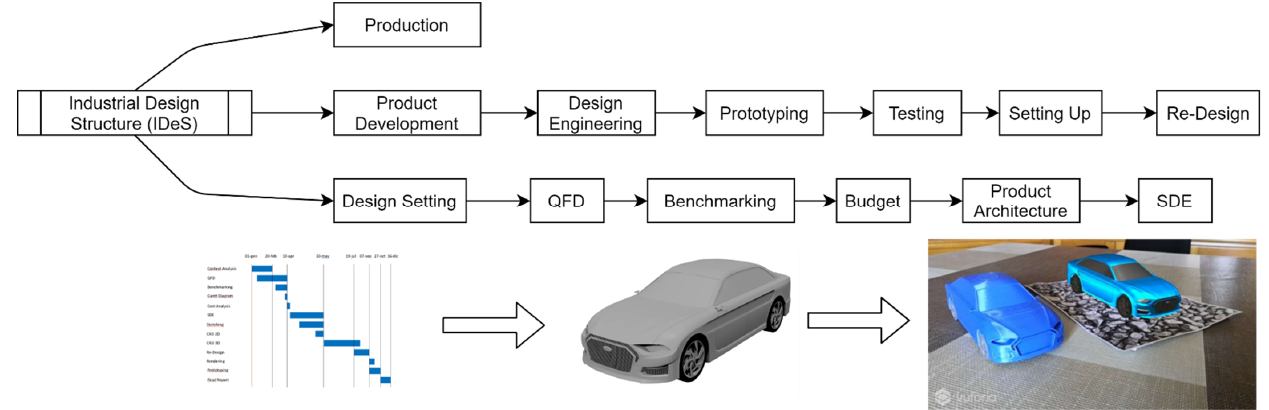
Figure 1. Paper architecture following IDeS phases and implementing AM and AR.